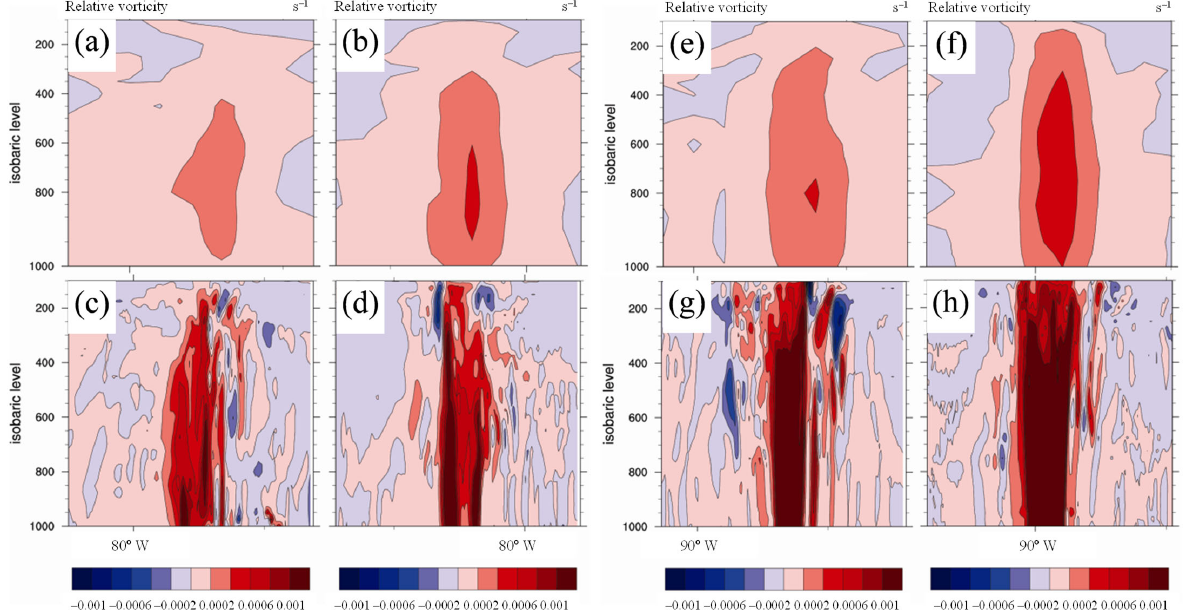
Figure 8. Cross ‐ sections showing the relative vorticity (s − 1 ) of the TC according to ( a , c , e , g ) 24 and ( b , d , f , h ) 48 h forecasts taken from the GFS (upper panels) and HRS/HLAPS (lower panels). The left and right panels are for Hurricanes Dennis and Katrina, respectively.